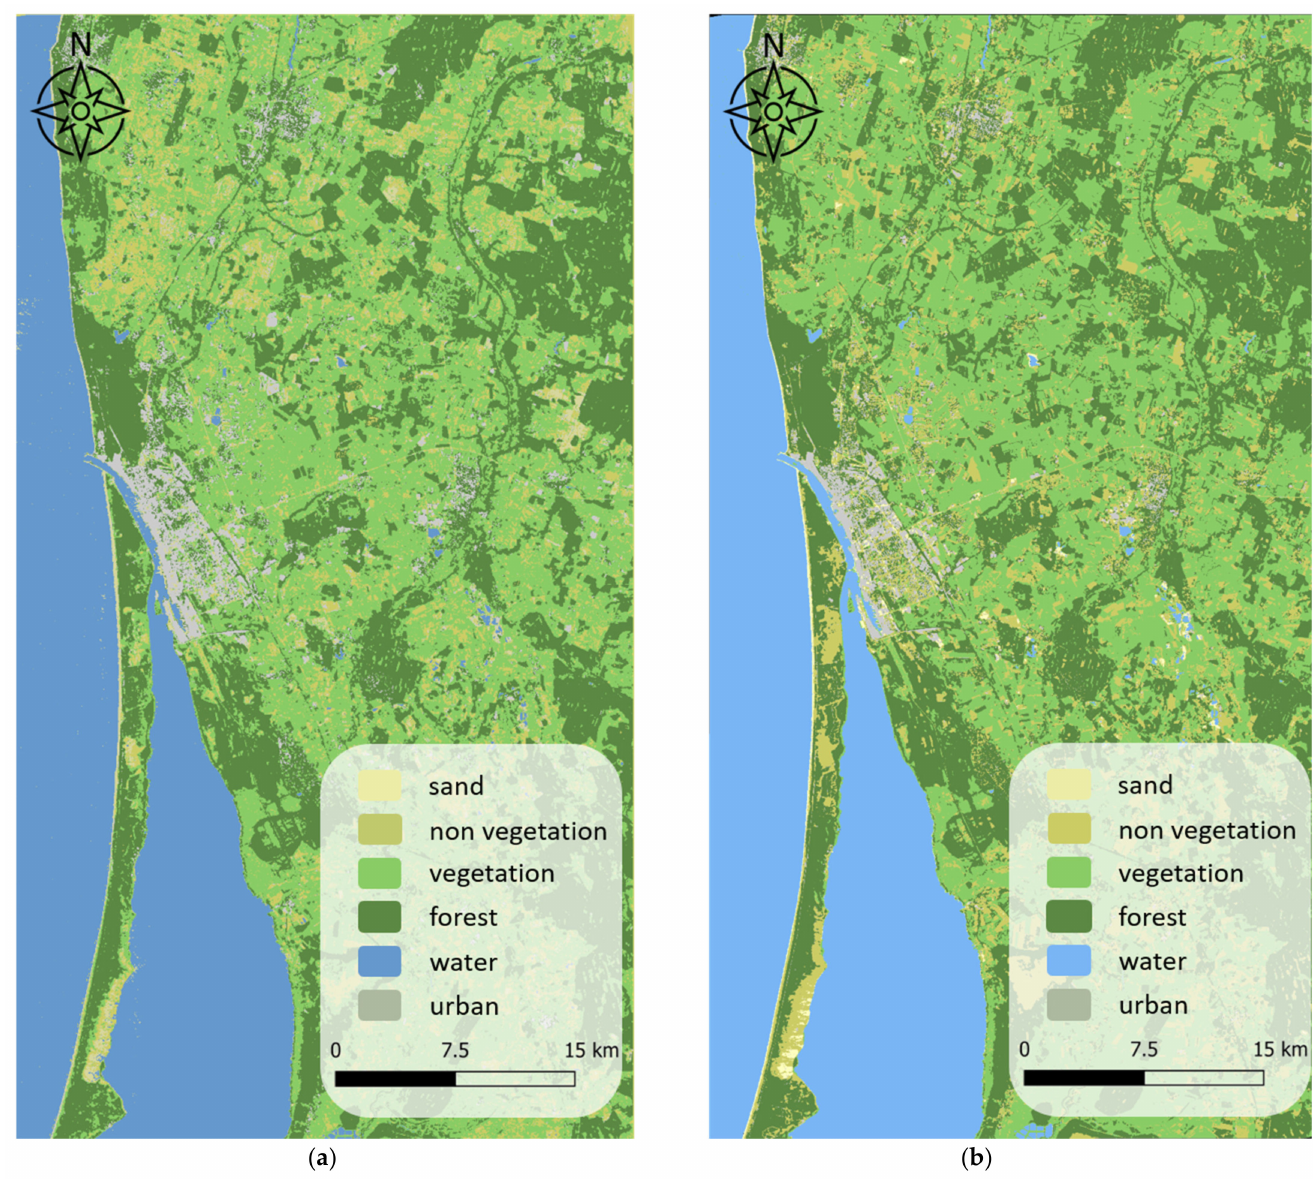
Figure 13. Segmentation result ( a ) 2018 ( b )